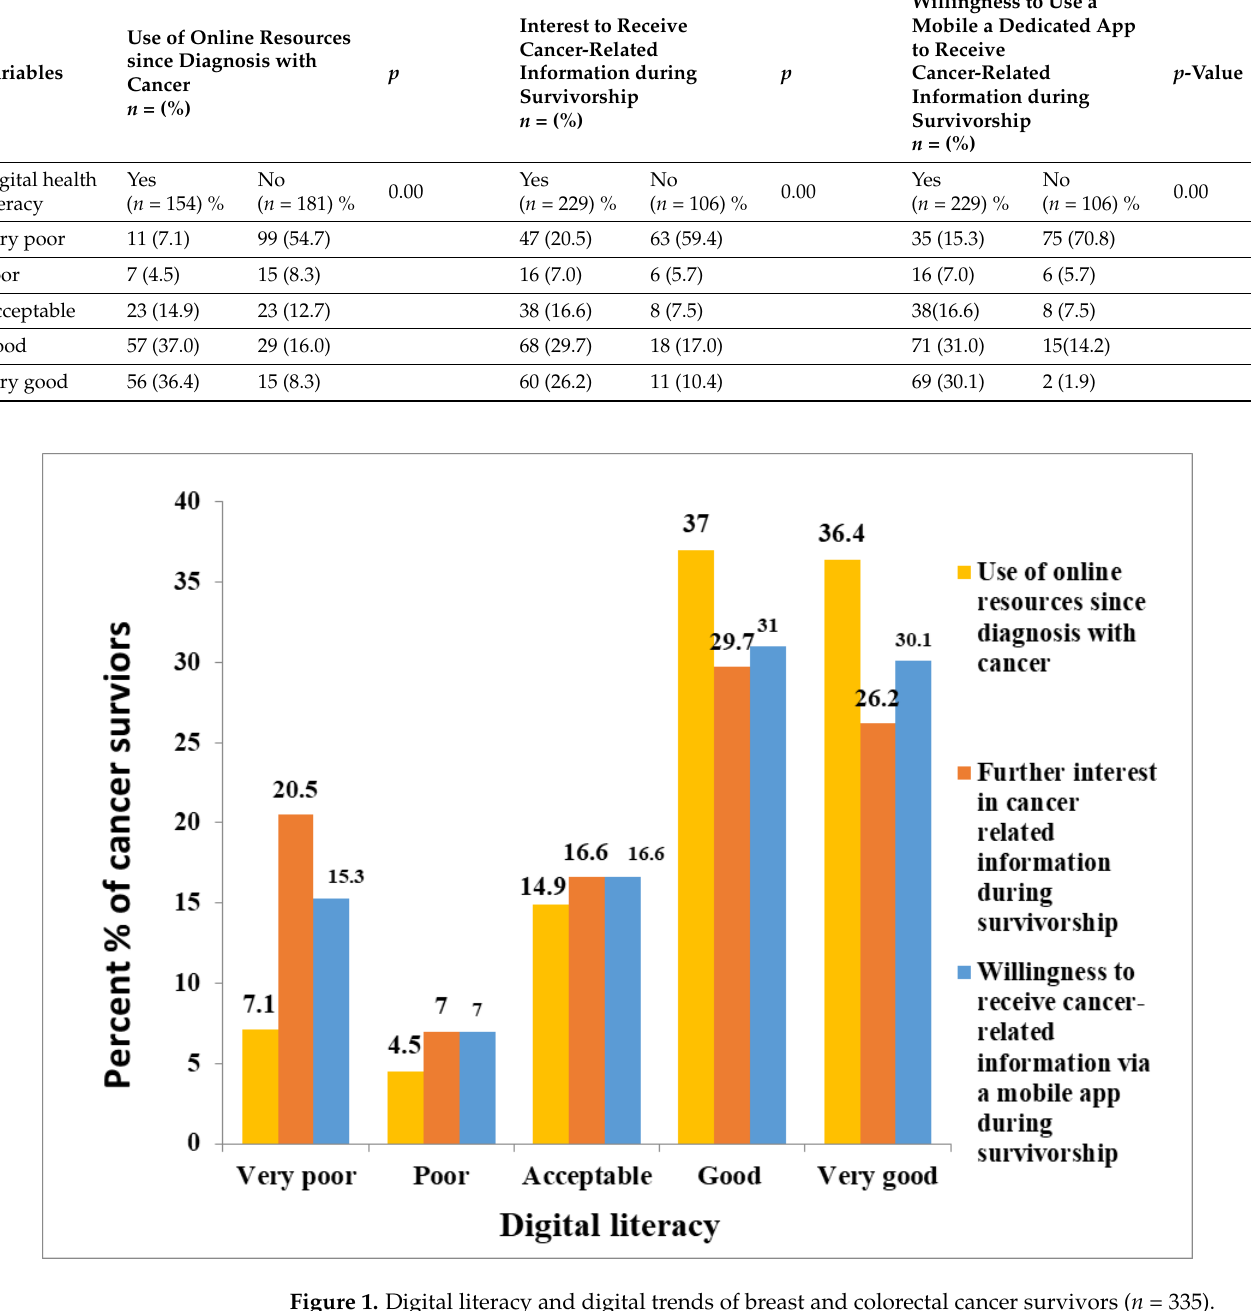
Figure 1. Digital literacy and digital trends of breast and colorectal cancer survivors ( n = 335).